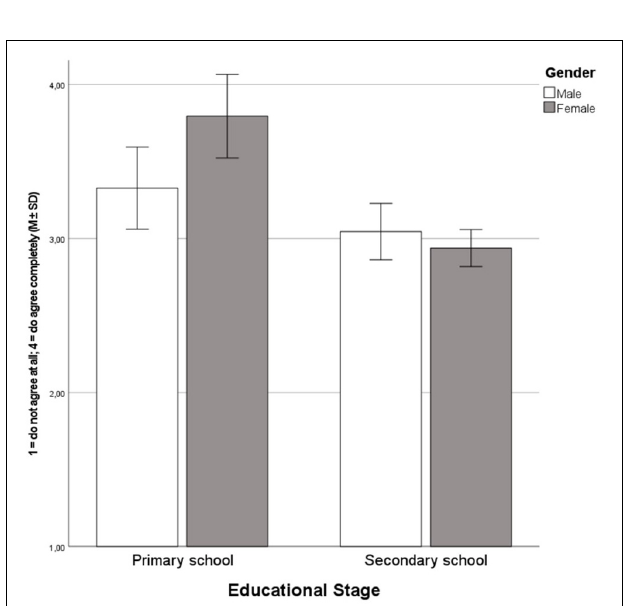
FIGURE 2 | Interaction effect of gender and educational stage on students’ experiences of social distancing.